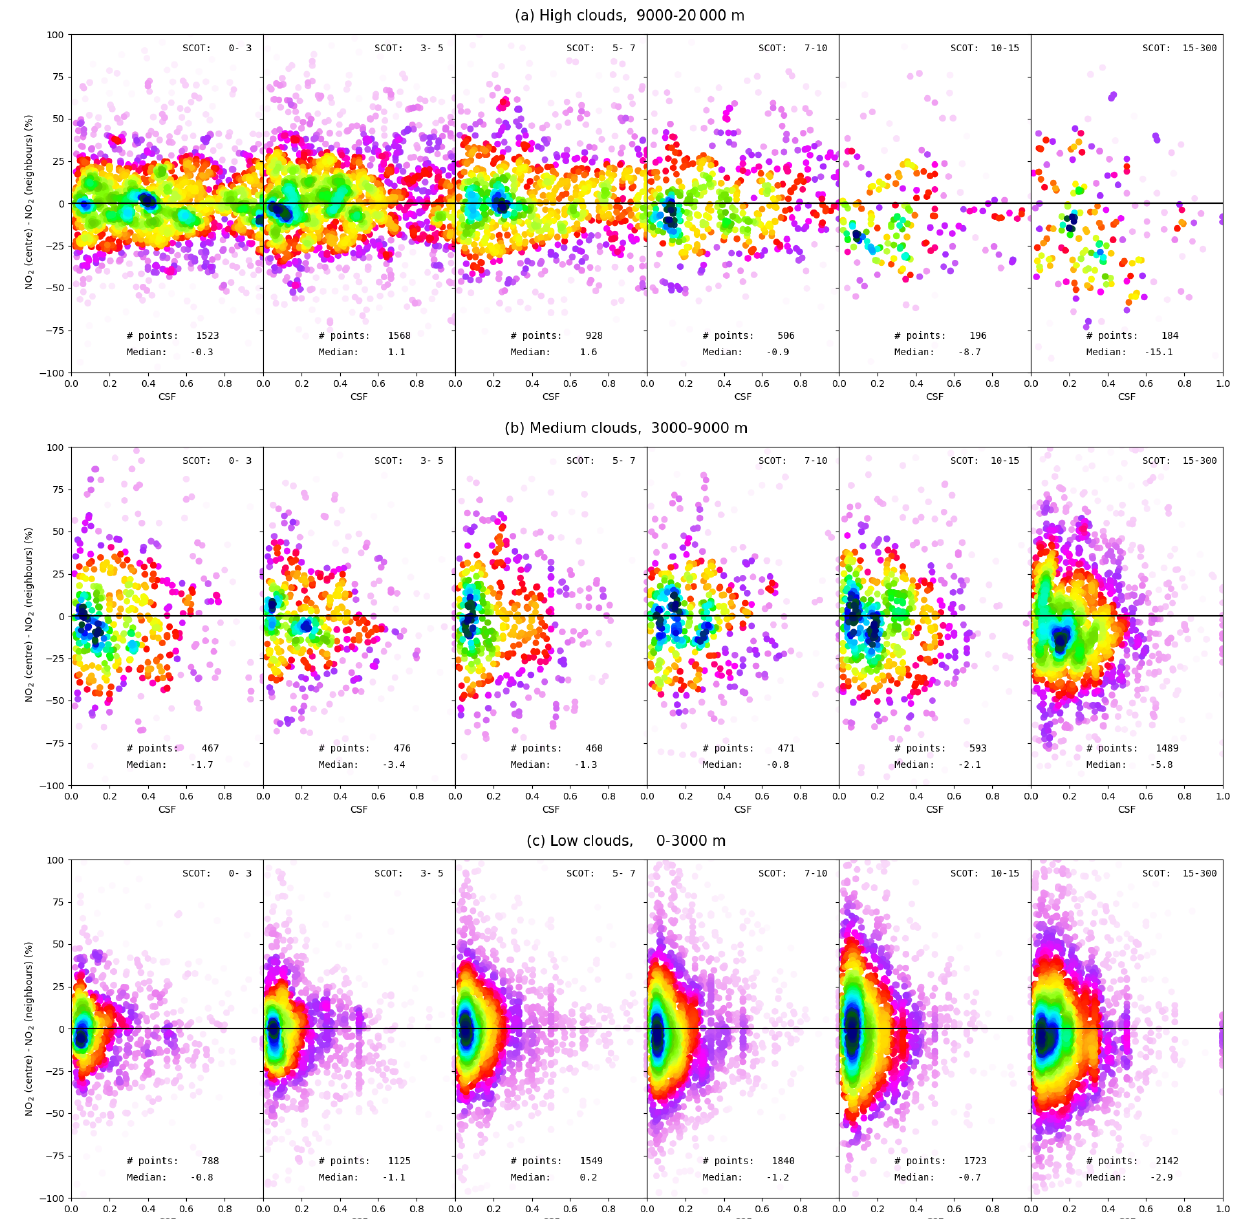
Figure 10. The NO 2 bias density as a function of the cloud shadow fraction. The data are binned into slant cloud optical thickness bins for high (a) , medium (b) and low (c) clouds. See text for further